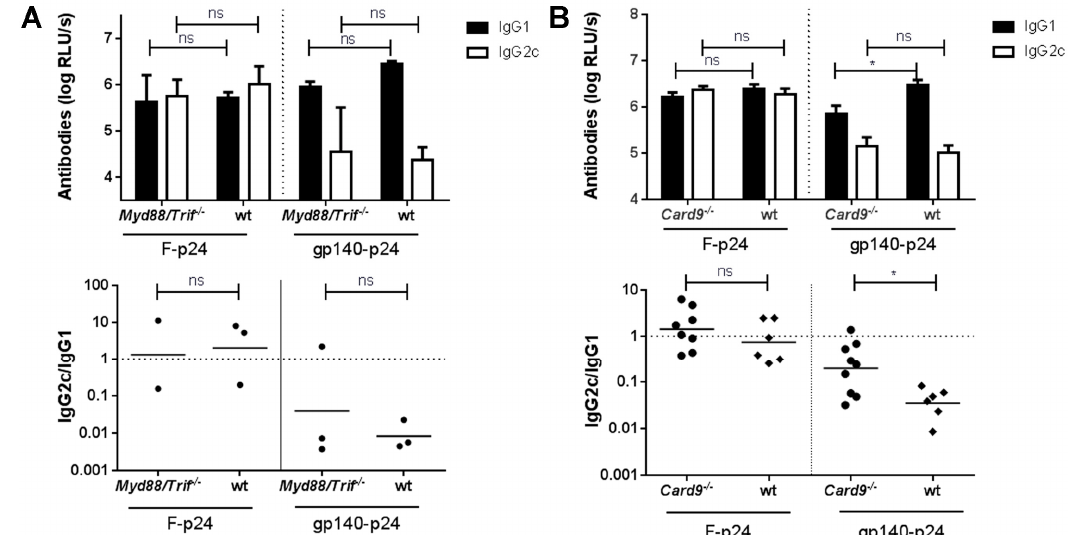
Figure 6. Impact of TLR- or CLR-signaling on the antibody response. Myd88/Trif -/- ( A ) or Card9 -/- ( B ) mice were immunized with either F-p24 or gp140-p24 as described above and compared to WT C57Bl/6J mice. The levels of IgG1- and IgG2c specific for RSV-F or HIV-Env were determined by ELISA at a serum dilution of 1:1000 for both knock-out strains. Again, the IgG2c/IgG1 ratios were calculated for the individual animals represented by the symbols ( n = 2–3 for Myd88/Trif -/- ; n = 6–9 for Card9 -/- ). The bars represent the mean values with SEM (top), whereas the lines represent the geometrical mean for each vaccine group (bottom) (* p < 0.05, ns = not significant, Student’s t-test).